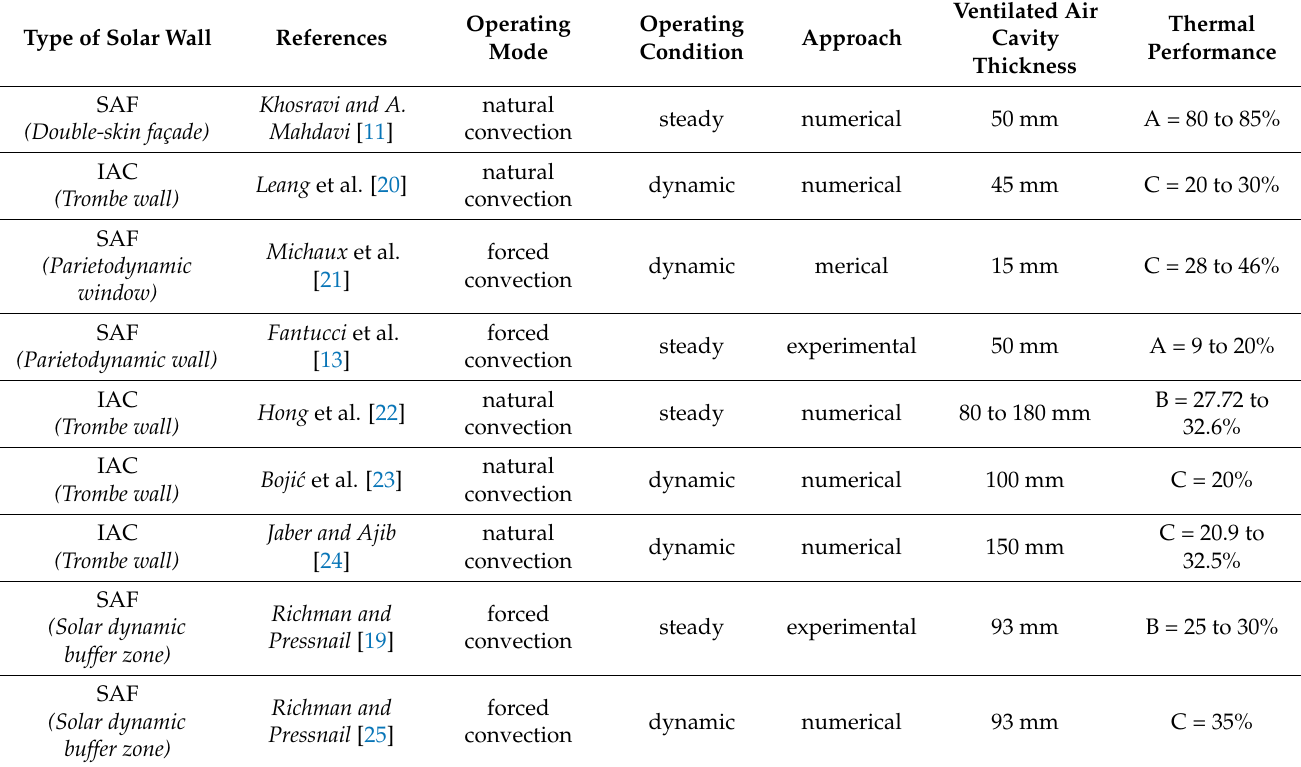
Table 1. Characteristics of a selection of solar wall